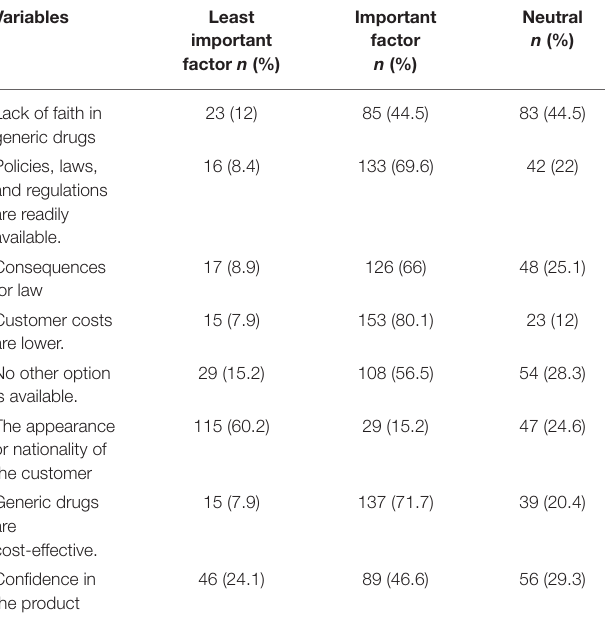
TABLE 2 | Possible factors influencing generic drug